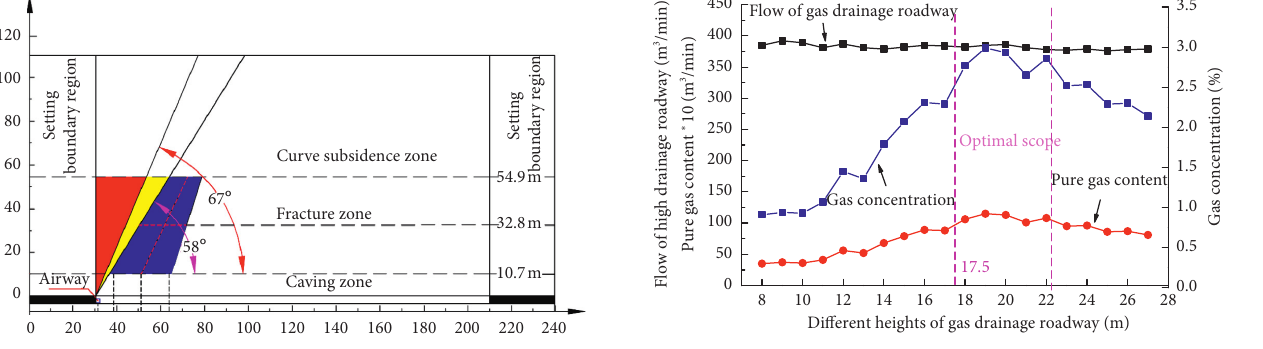
Figure 7: Layout of the gas drainage roadway.